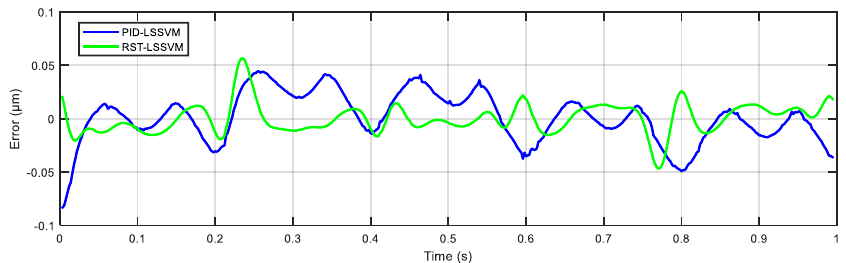
Figure 19. Tracking errors of the RST-LSSVM control scheme compared with the PID-LSSVM control scheme on data I.